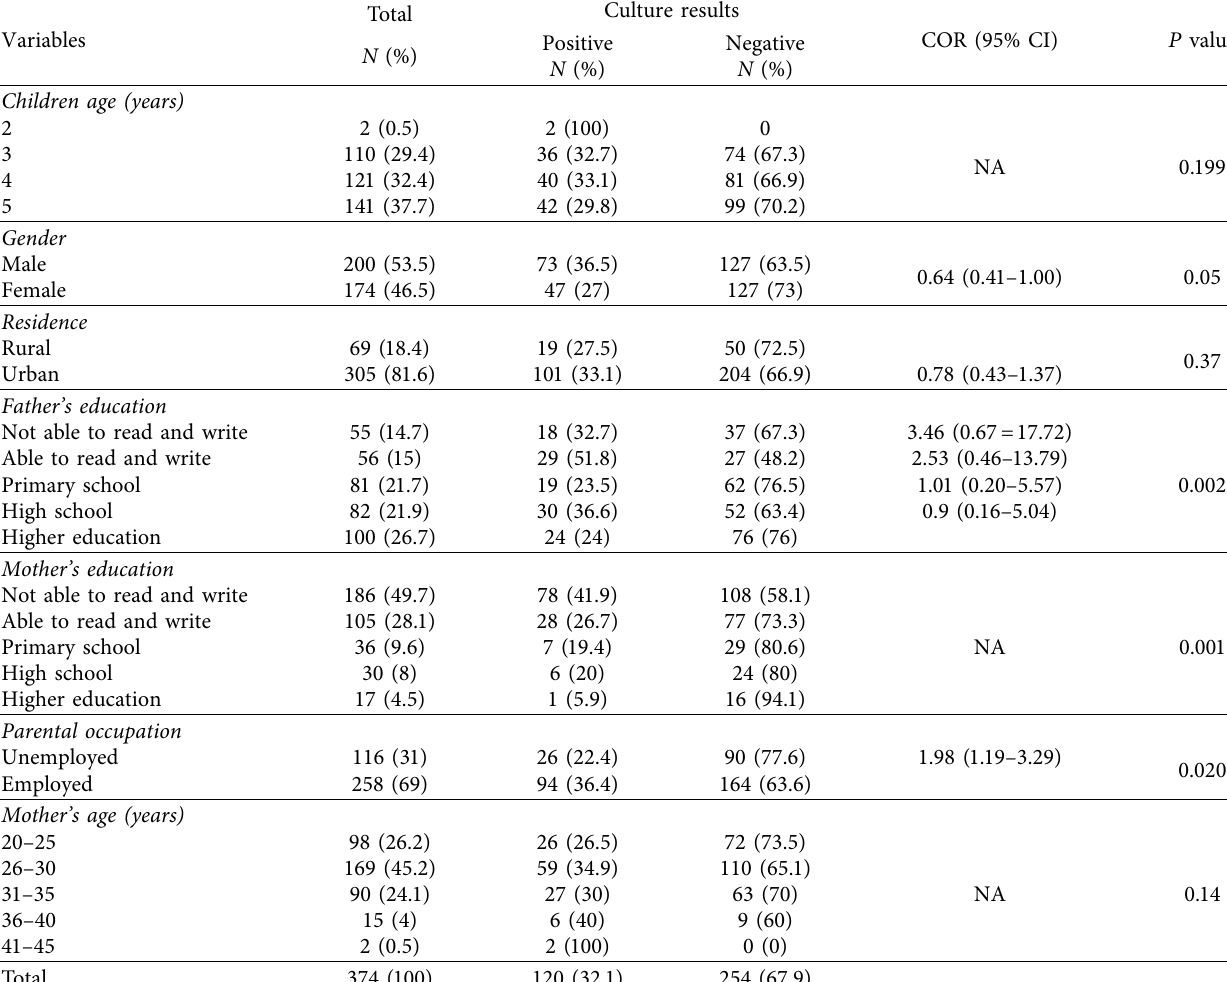
Table 1: Bacterial throat culture positivity among children 2–5 years of age with suspicion of bacterial tonsillitis at Hargeisa Group of Hospital ( N �